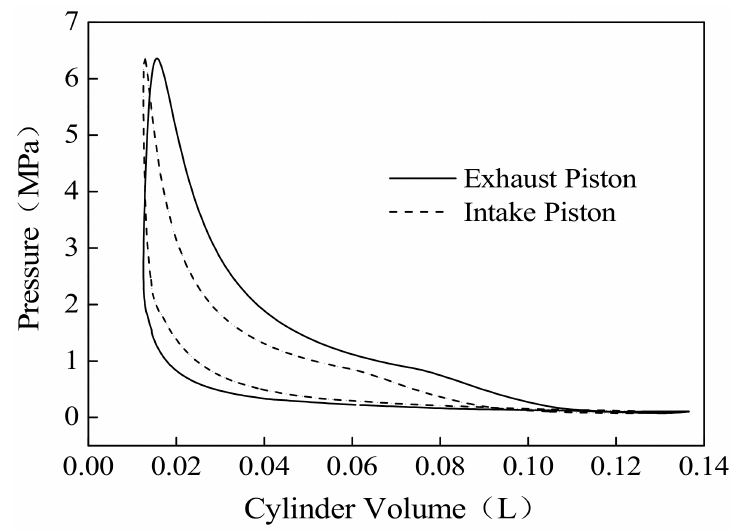
Figure 13. Indicated Work of Opposed-piston.